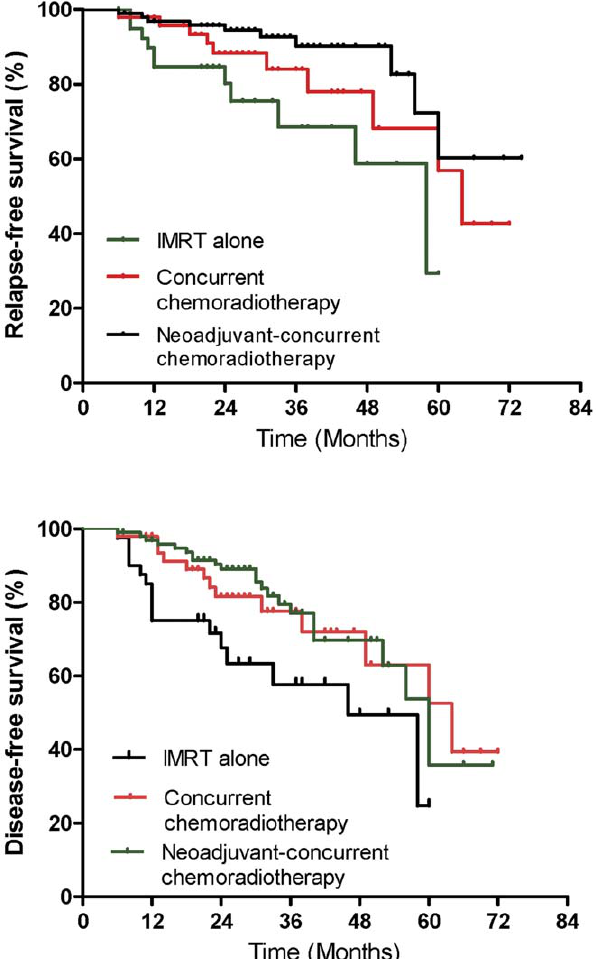
Figure 1. Kaplan-Meier estimates of relapse-free survival and disease-free survival for patients receiving Neoadjuvant- concurrent chemoradiotherapy versus Concurrent chemora- diotherapy versus IMRT